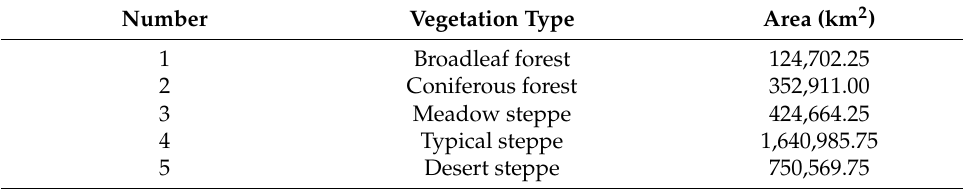
Figure 1. Study area: ( a ) DEM of the Mongolian Plateau; ( b ) distribution of different vegetation types. Table 1. Different vegetation types on the Mongolian Plateau.